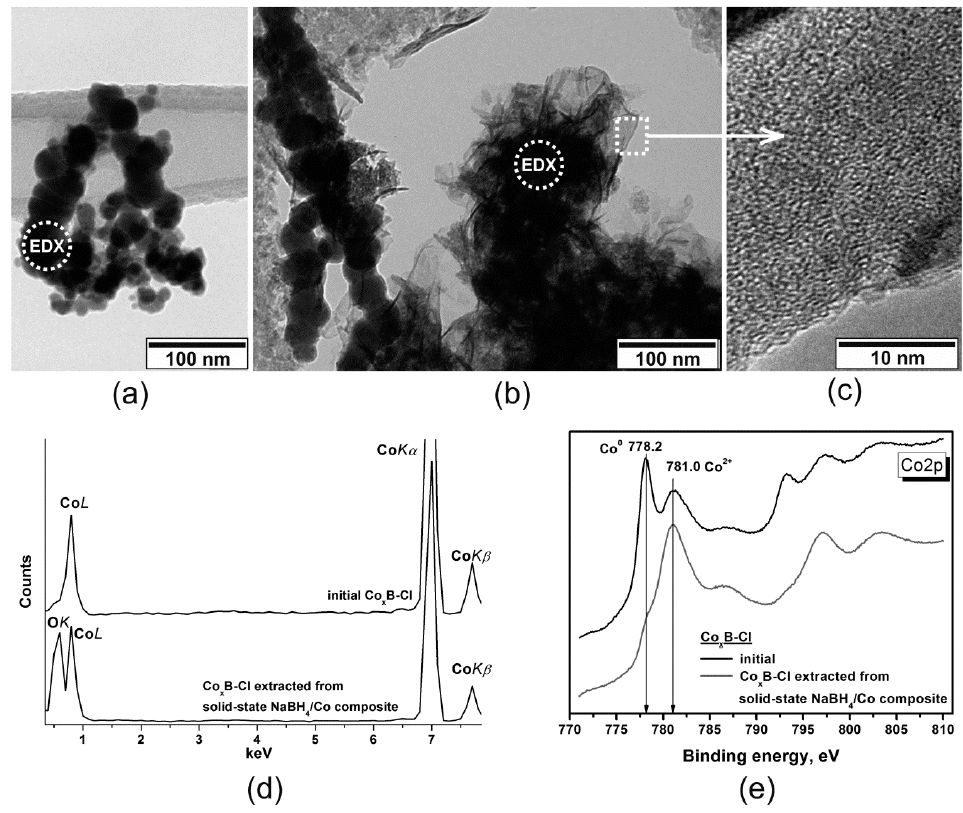
Figure 4. Morphology of ( a ) the initial Co x B-Cl catalyst and ( b ) the Co x B-Cl catalyst extracted from the solid-state NaBH 4 /Co composite with the molar ratio NaBH 4 :Co = 30:1; ( c ) the amorphous film without crystal lattice; ( d ) energy-dispersive X-ray microanalysis (EDX) from the chosen regions of the catalyst particles; ( e ) XPS spectra of the Co2p core level for these catalysts.